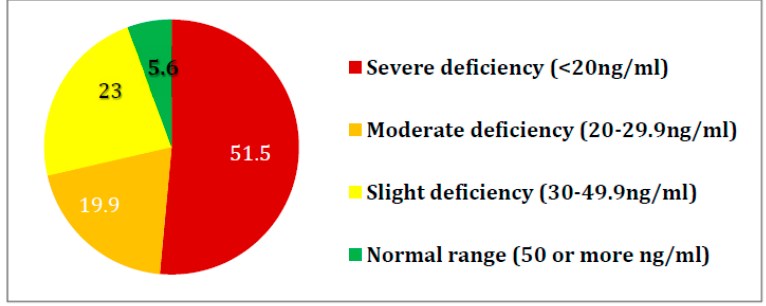
Figure 1. Structure of vitamin D level in geriatric patients ( n = 357, in %).